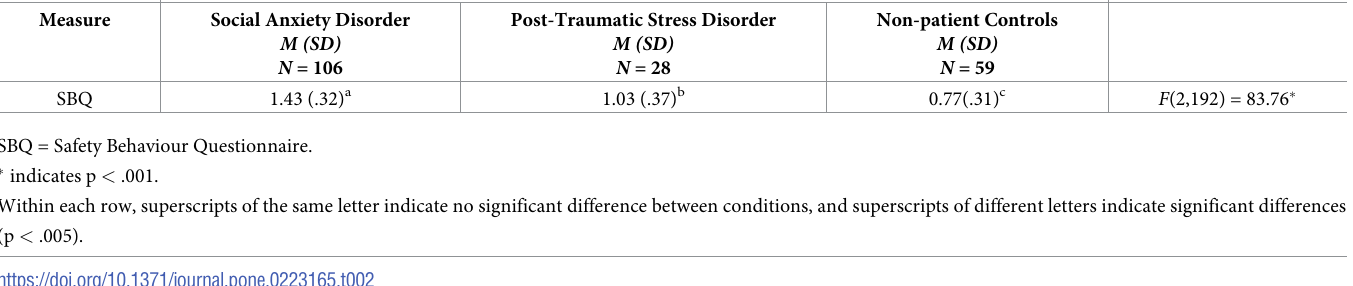
Table 2. Means and standard deviations (in parentheses) for social safety behaviour use (SBQ) in SAD, PTSD, and non-patient groups. Group Statistic Measure Social Anxiety